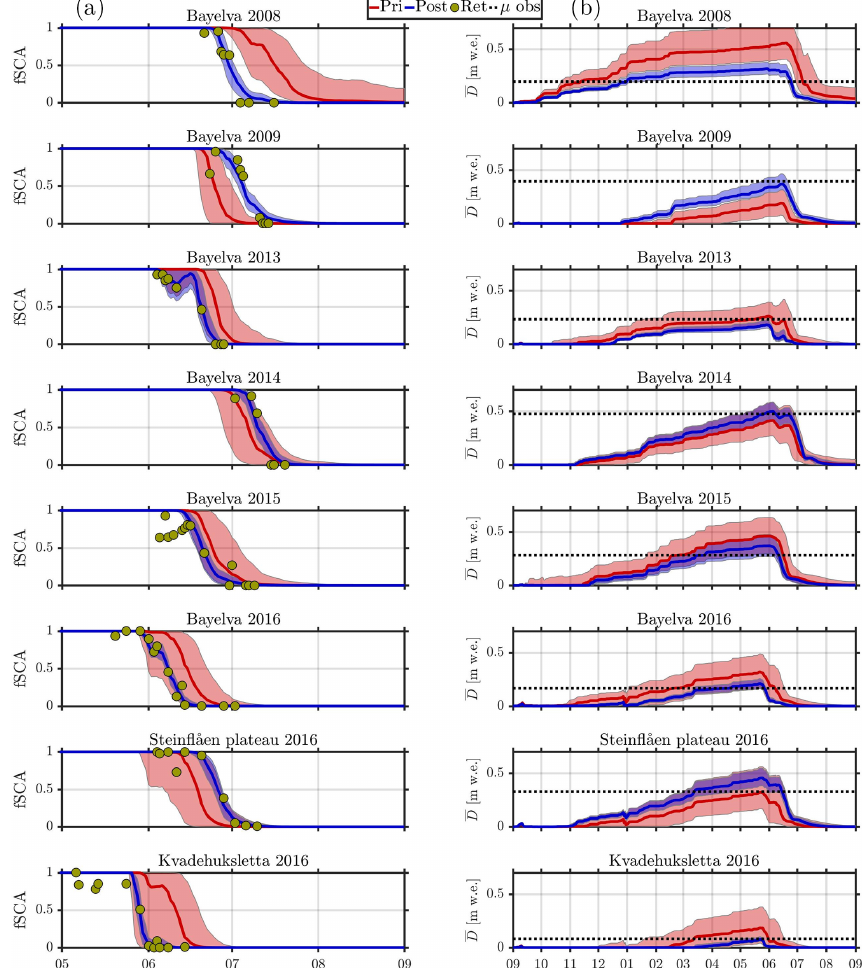
Figure 4. Time evolution of the prior (red) and ES-MDA ( N a = 4, N e = 10 2 ) posterior (blue) fSCA (column a ) and mean SWE ( D ; column b ); shading: 90th-percentile range; solid lines: ensemble median; yellow dots: assimilated MODIS and Sentinel-2 fSCA retrievals; dotted black line: independently observed peak mean SWE ( µ ) from snow surveys (Sect. 2.2); x axis: months. These results are from a single